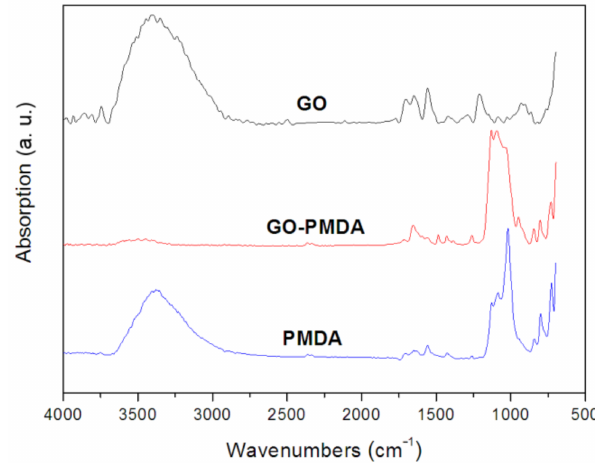
Figure 2. FTIR spectra of GO, PMDA, and